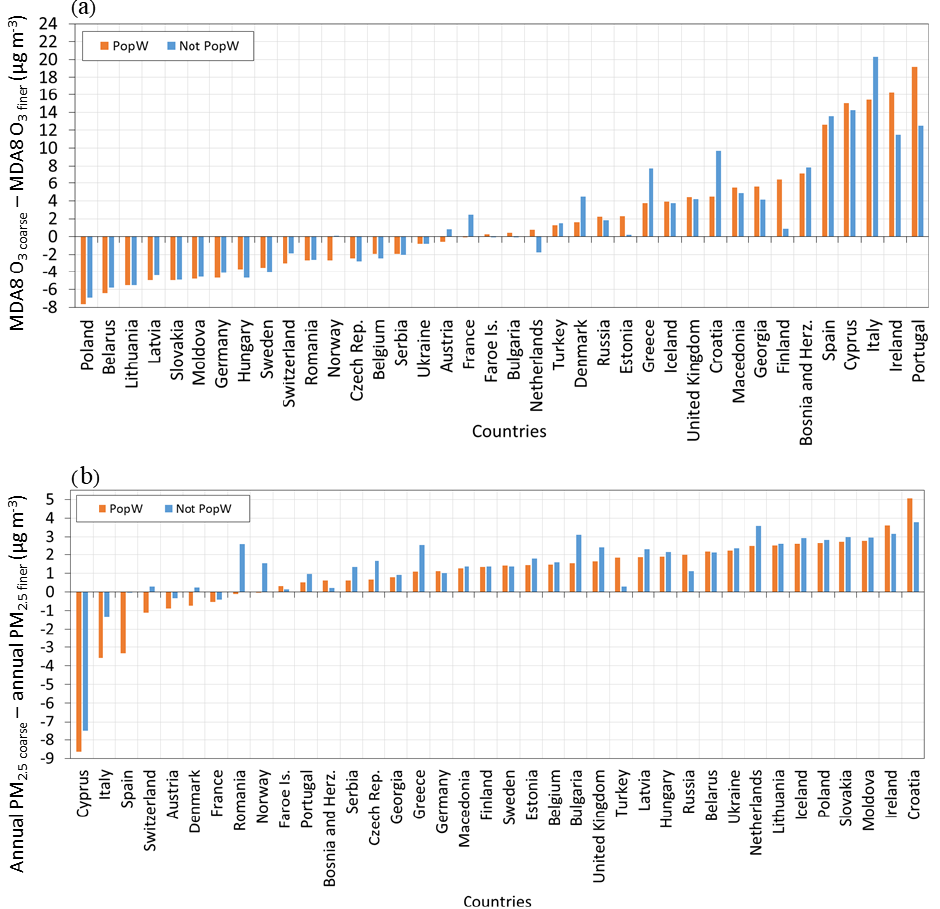
Figure 6. (a) Differences between warm season mean daily maximum 8h running mean (MDA8) O 3 concentrations simulated at the two resolutions (coarse − finer) for population-weighted (PopW) concentrations (orange bars) and concentrations with no population-weighting (Not PopW) (blue bars) (b) The same as (a) but for annual mean PM 2 . 5 concentrations. Countries are ordered by differences in PopW pollutant concentrations between the two